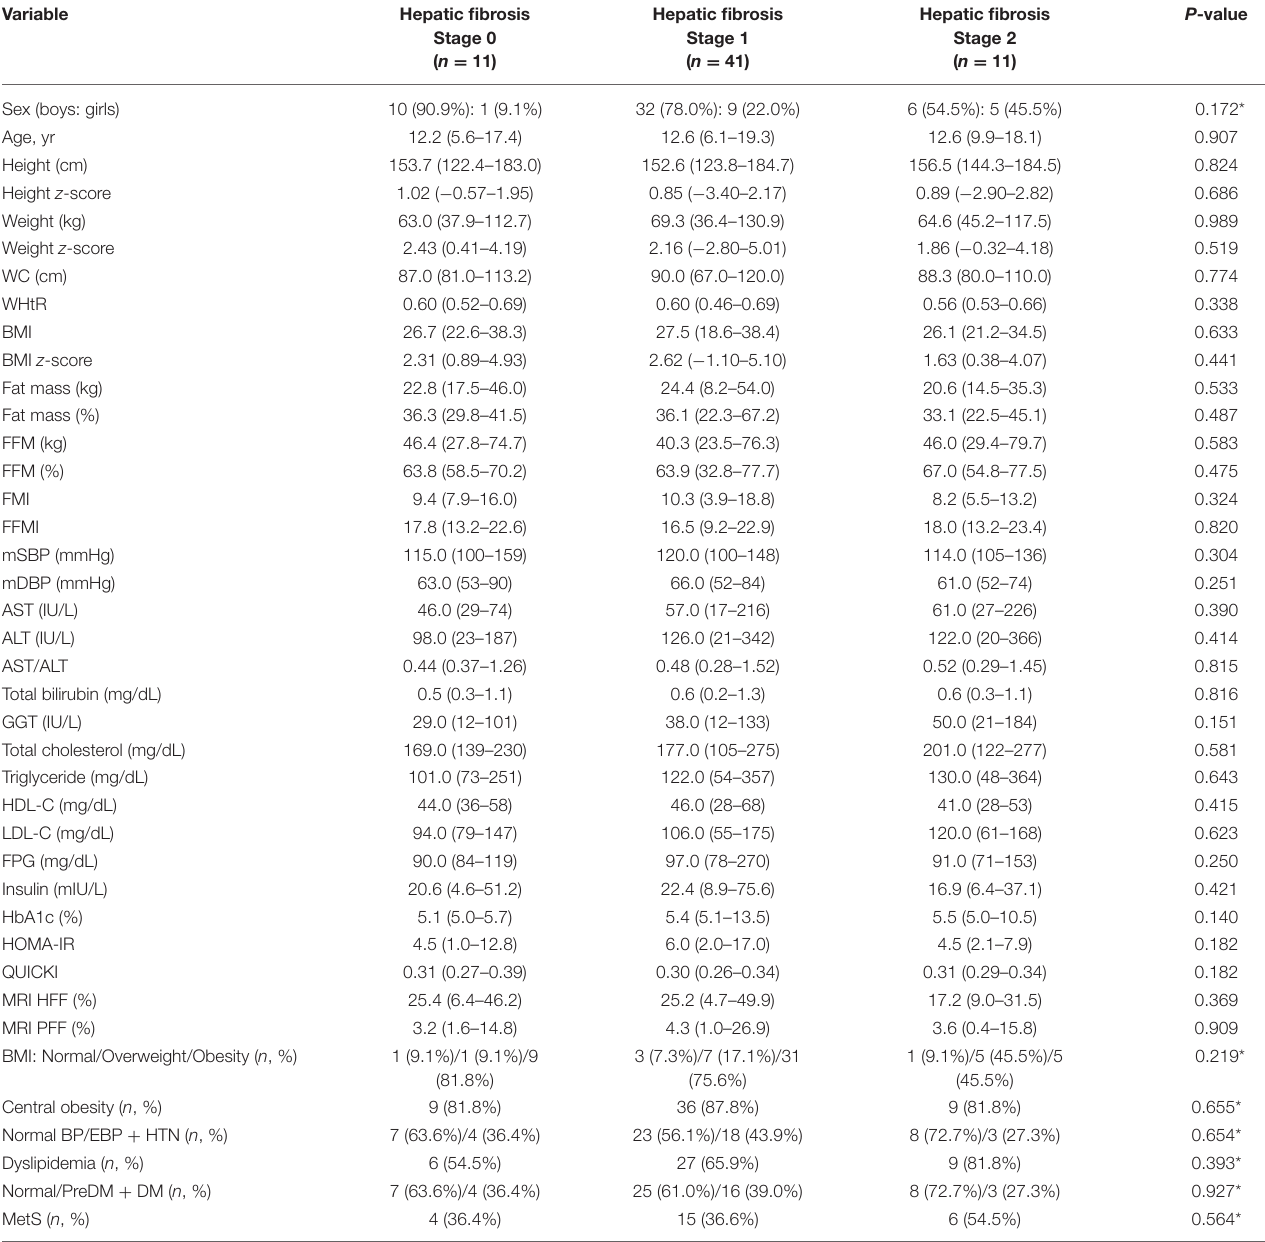
TABLE 5 | Comparison of demographic, anthropometric, laboratory, and magnetic resonance imaging-measured fat fraction findings of 63 children with non-alcoholic fatty liver disease by liver histologic fibrosis